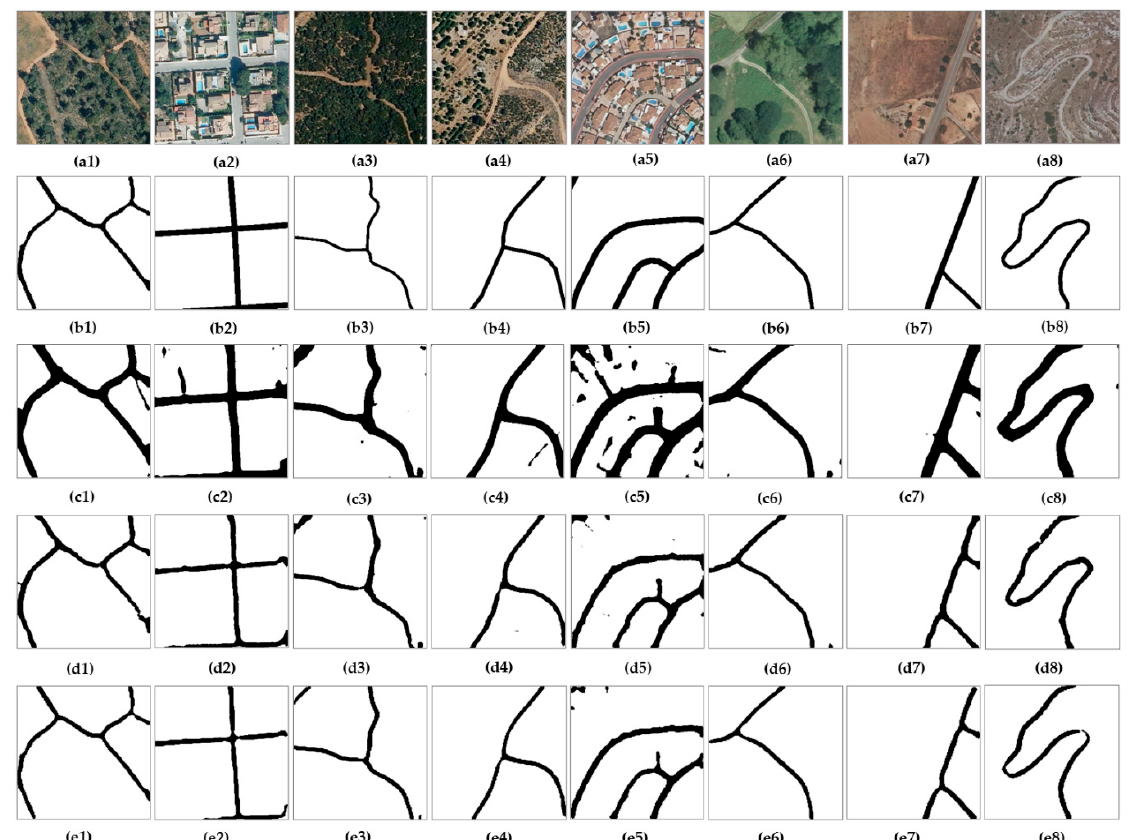
Figure 7. Perceptual validation carried out on eight random tiles from the test set (data unseen during training). The first row ( a1 – a8 ) represents the aerial orthoimage, the second row ( b1 – b8 ) represents the ground truth mask (target domain, y ), the third row ( c1 – c8 ) represents the initial semantic segmentation prediction (conditional information, x ), the fourth row ( d1 – d8 ) presents the predictions obtained with the original Pix2pix, and the fifth row ( e1 – e8 ) presents the prediction obtained by the model proposed in this paper.